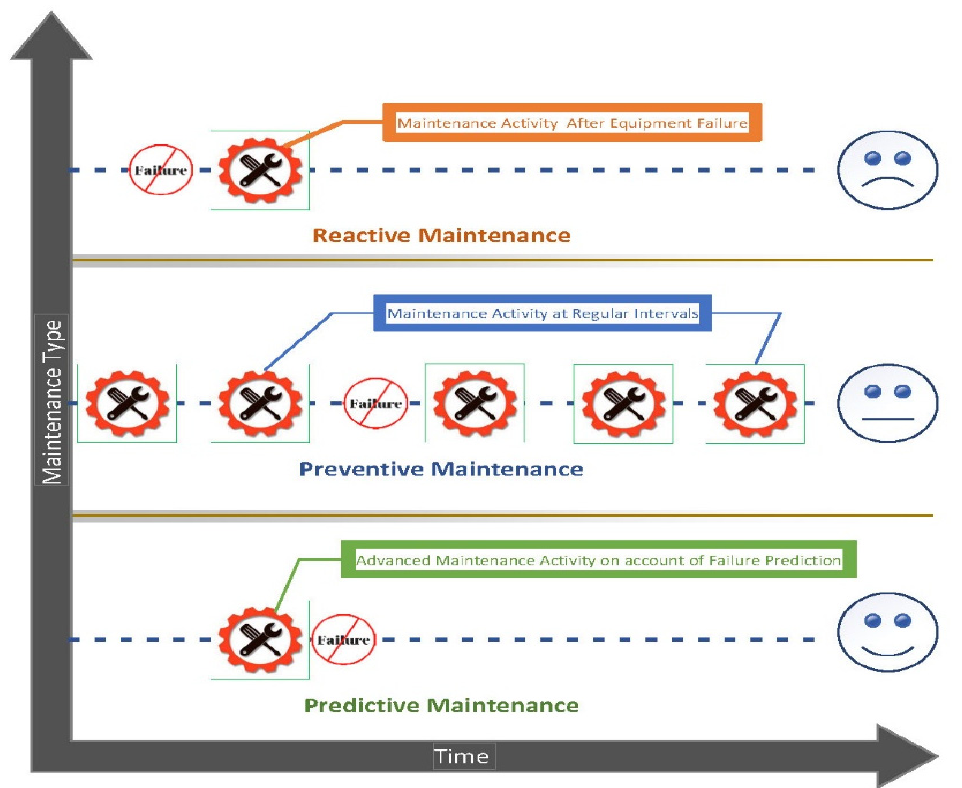
Figure 3. Effectiveness of PdM.